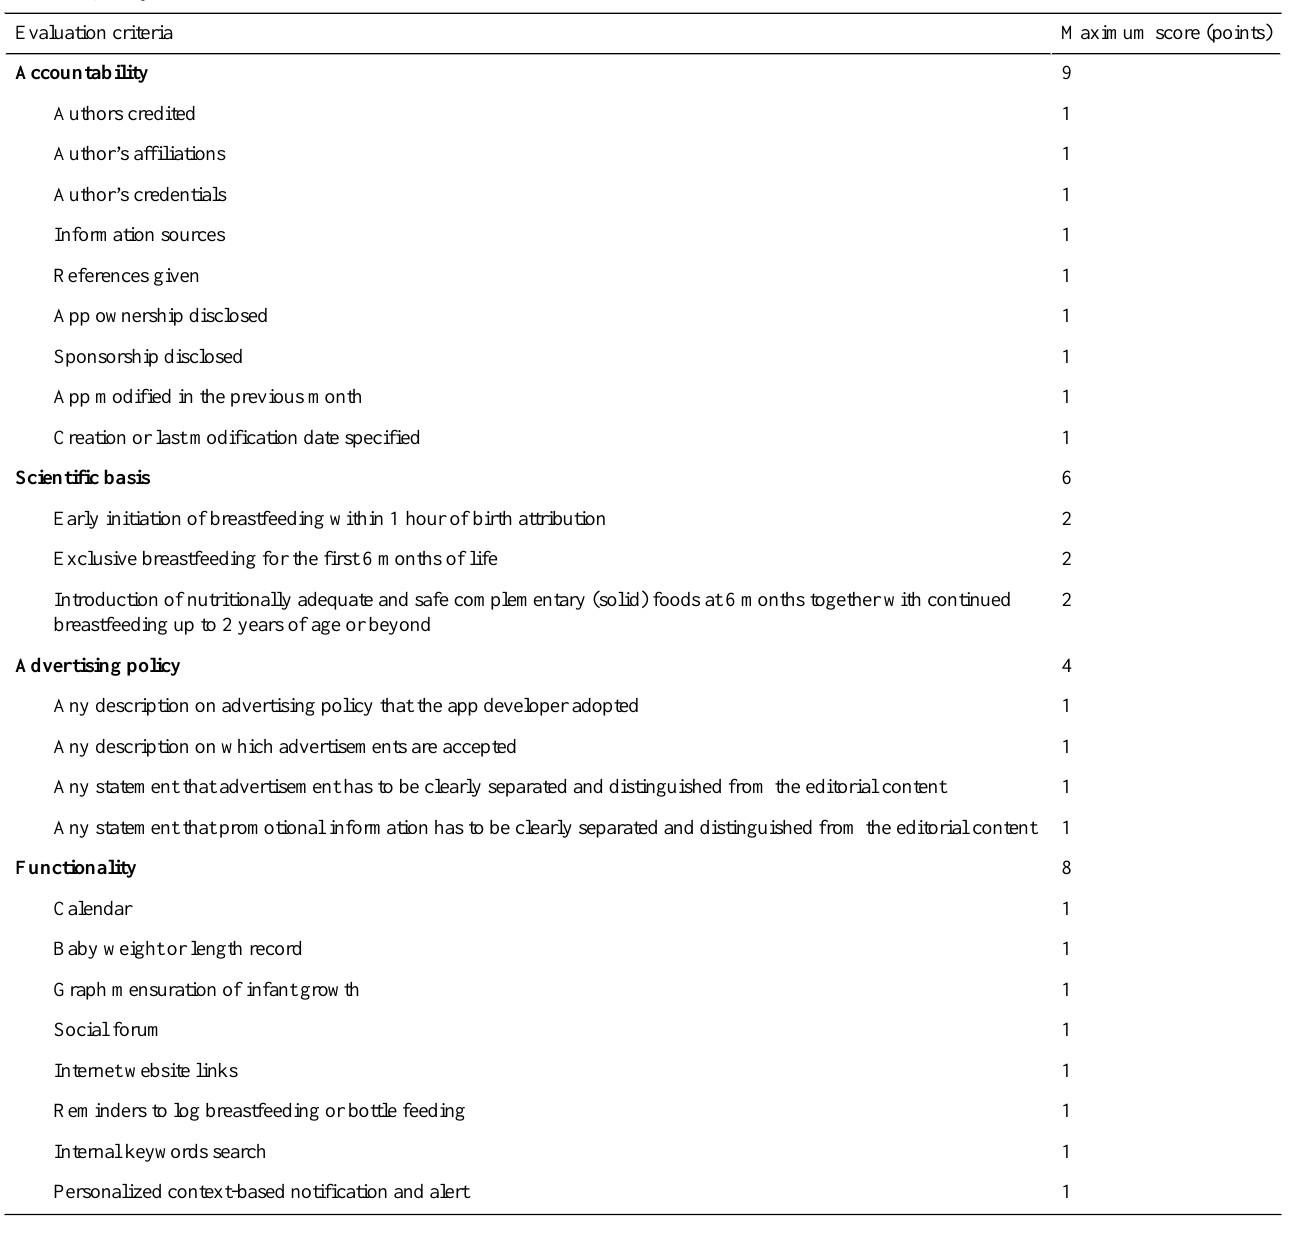
Table 1. Quality assessment evaluation